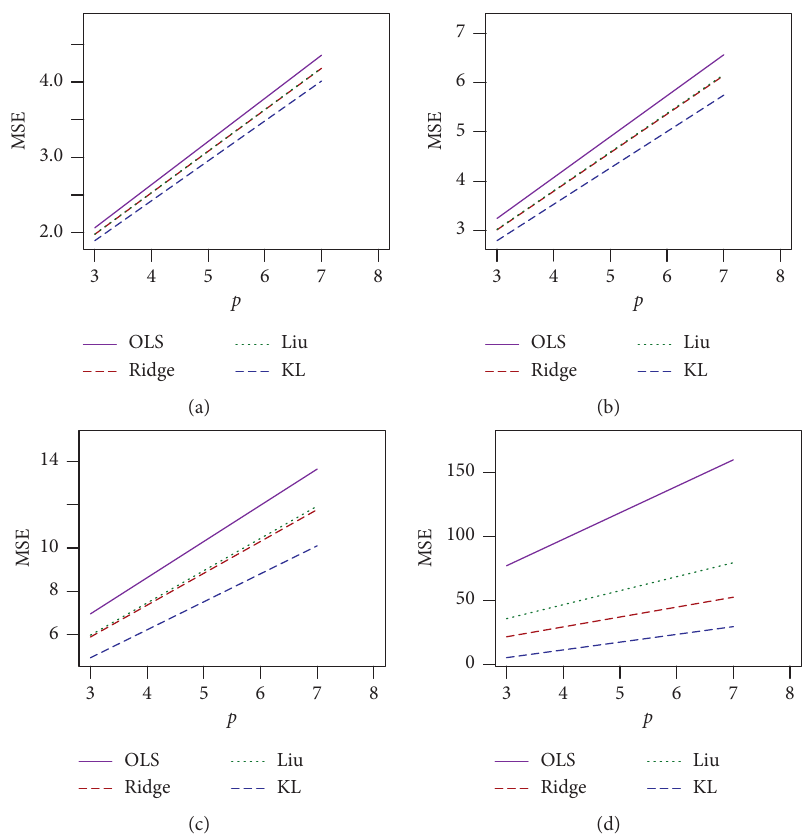
Figure 5: Estimated MSEs for n � 100, d � 0.5, sigma � 5, and different values of rho and p . (a) n � 100, sigma � 5, d � 0.5, and rho � 0.70. (b) n � 100, sigma � 5, d � 0.5, and rho � 0.80. (c) n � 100, sigma � 5, d � 0.5, and rho � 0.90. (d) n � 100, sigma � 5, d � 0.5, and rho �